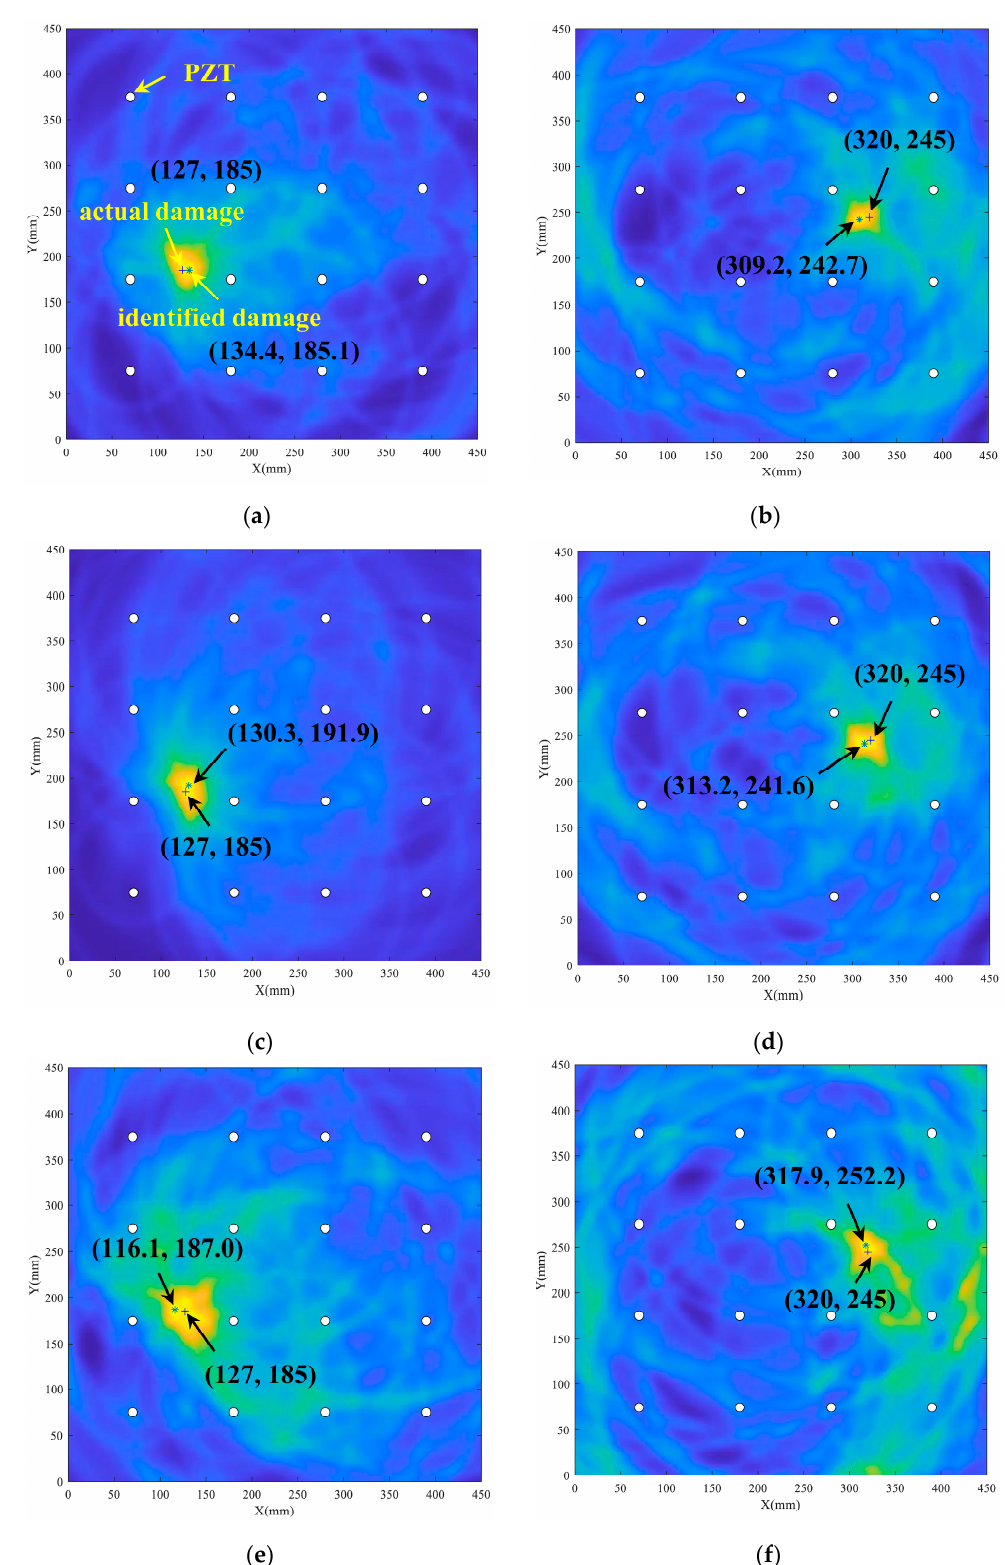
Figure 10. Damage localization results at different locations and sizes. ( a ) damage center (127, 185) and d = 4 mm; ( b ) damage center (320, 245) and d = 4 mm; ( c ) damage center (127, 185) and d = 8 mm; ( d ) damage center (320, 245) and d = 8 mm; ( e ) damage center (127, 185) and d = 12 mm; ( f ) damage center (320, 245) and d = 12 mm.